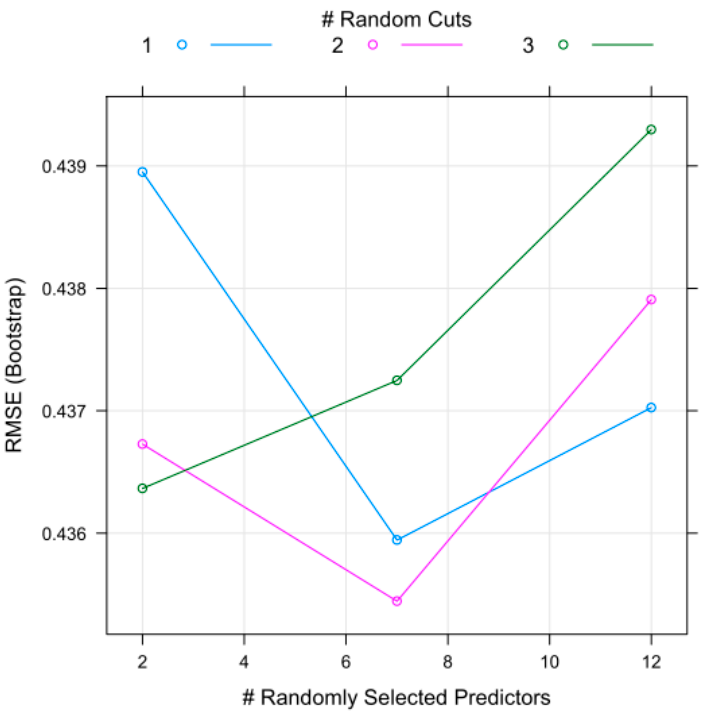
Figure 6. Evaluation parameters in ERT mode.